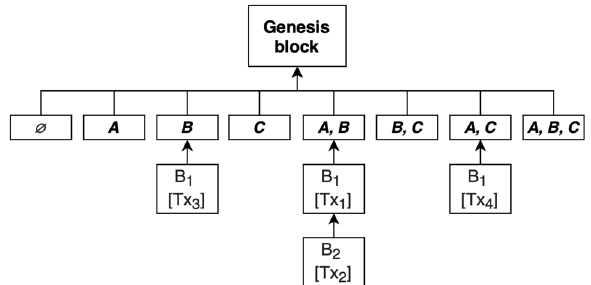
Figure 1. Blockchain has multiple subchains derived from the participants of the network for every business scope. Here is presented an example of blockchain with participants A , B and C